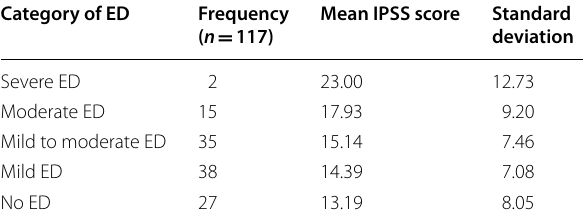
Table 6 Correlation between severity of ED and mean IPSS